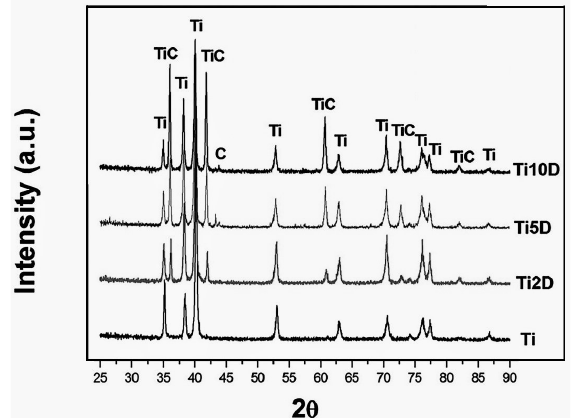
Figure 5 - XRD patterns of the samples.